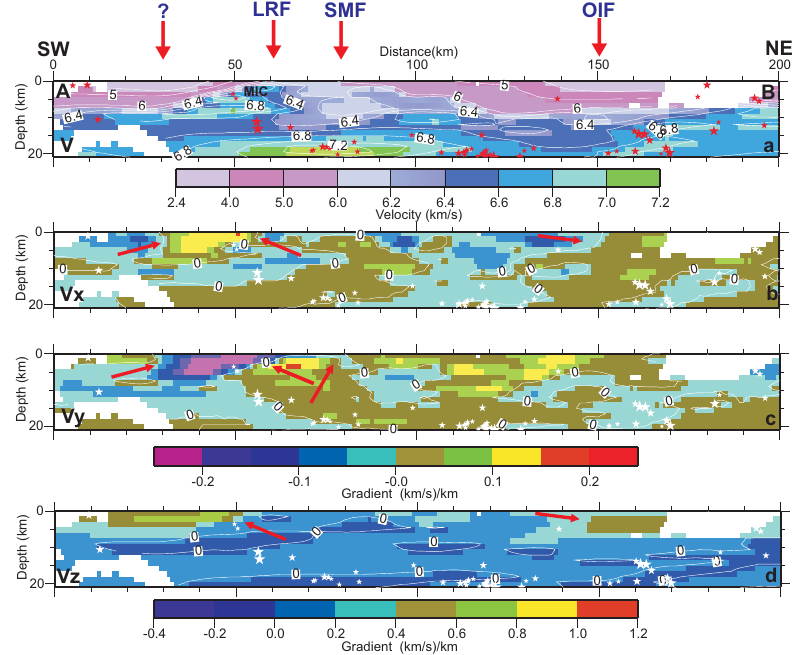
Fig. 2. Profile AB. Vertical cross-section of (a) tomographic velocity model (b) X gradient of velocity model, (c) Y gradient of velocity model, and (d) Z gradient of velocity model. MIC – Metchosin Igneous Complex. Abbreviations as in Fig. 1.